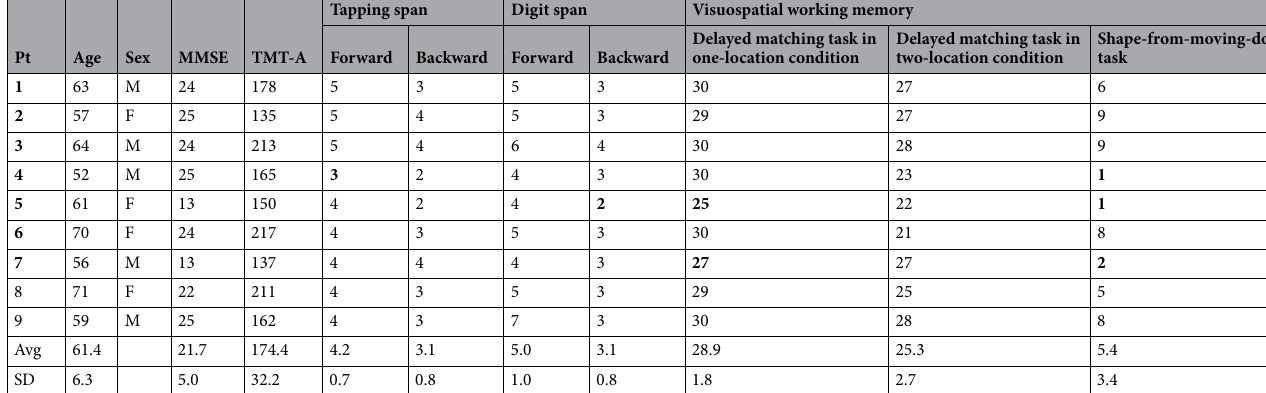
Table 3. Individual results of neuropsychological assessment for patients with amnesic Alzheimer’s disease. MMSE Mini-Mental State Examination, TMT-A Trail Making Test-A. Values in bold font represent those of below 5% tile.